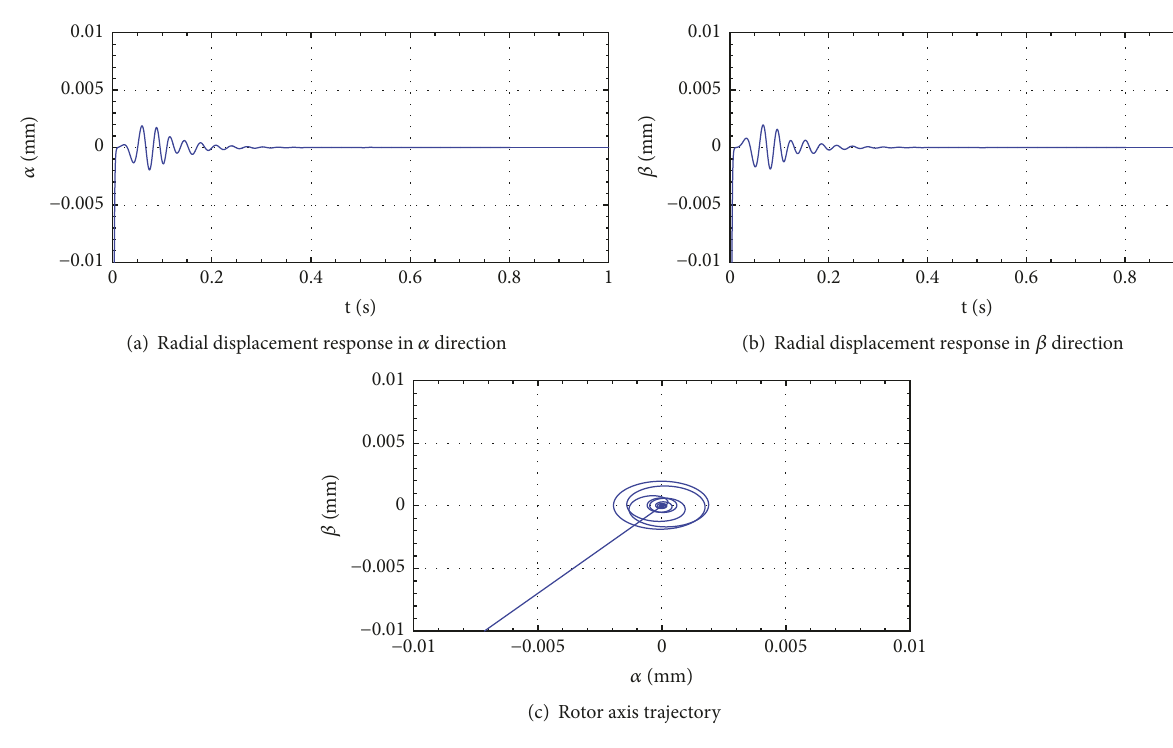
Figure 7: Displacement curves after vibration